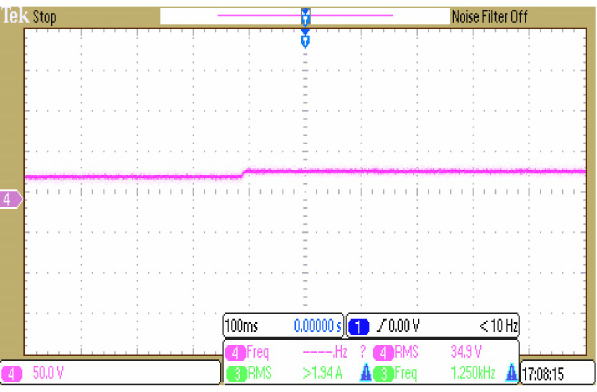
Figure 19. The output voltage waveform of load #1 after load #2 starts.